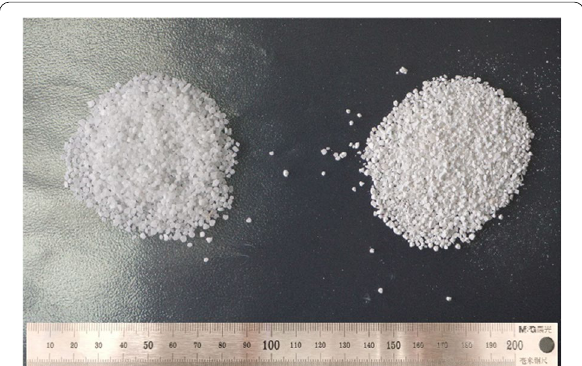
Fig. 2 Appearance of the calcareous sand before (left) and after (right) heat treatment